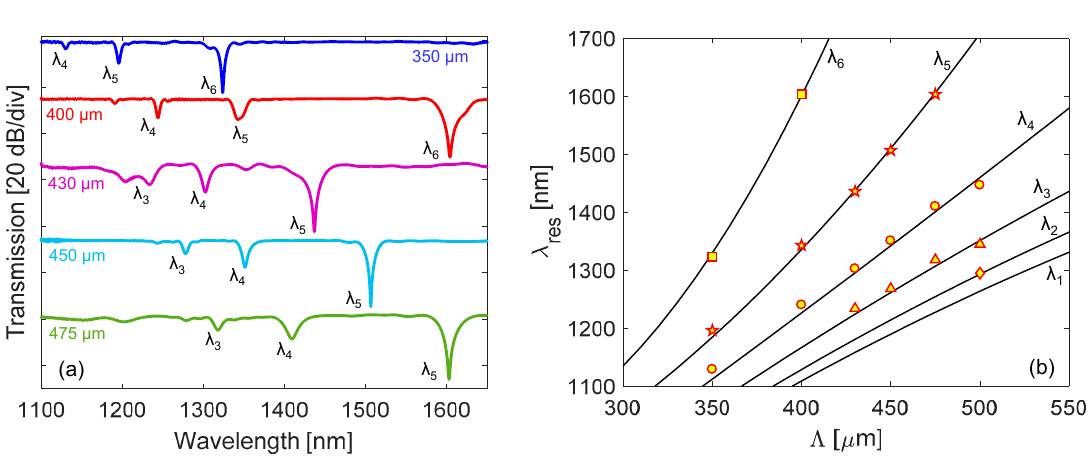
Figure 5. ( a ) Transverse section of Panda type polarization-maintaining fiber (PMF) model PM1300- XP; ( b ) Transmission spectra of arc-induced LPG in the fiber for fast and slow axis polarization.